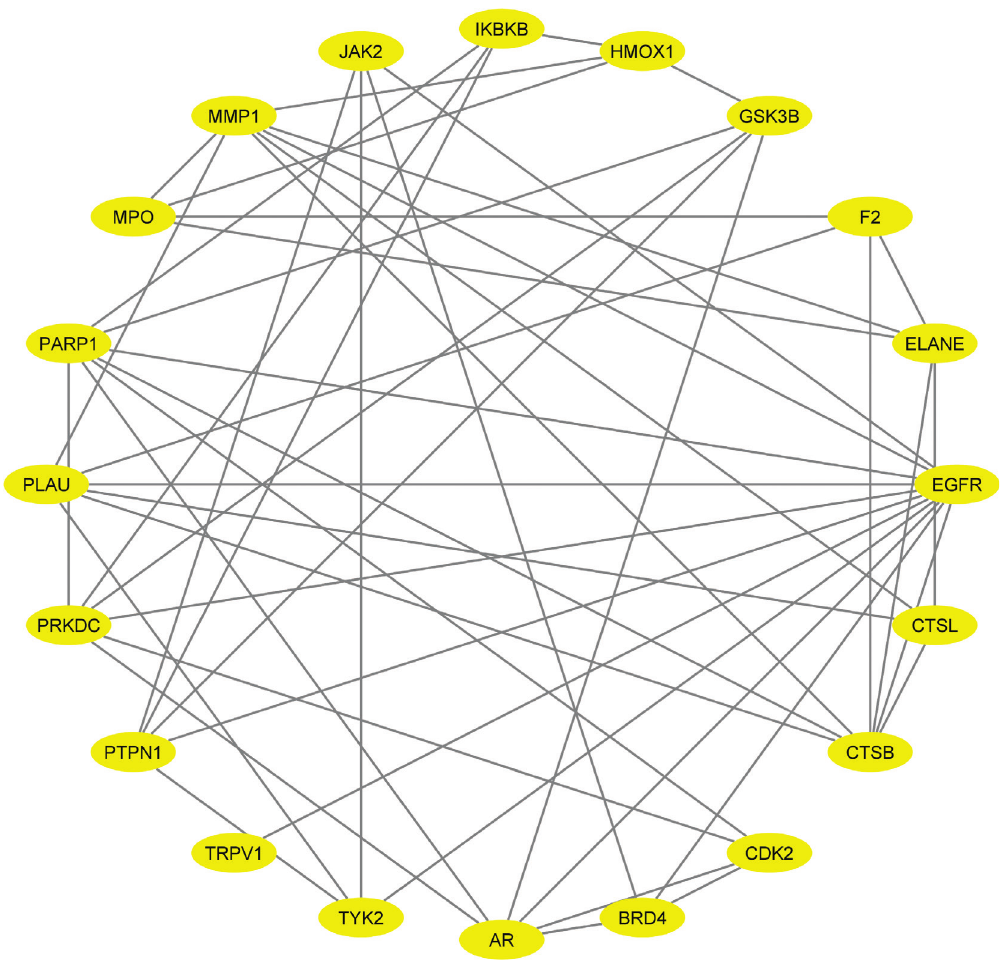
Figure 3. The PPI interaction between top 20 targets of CSL in